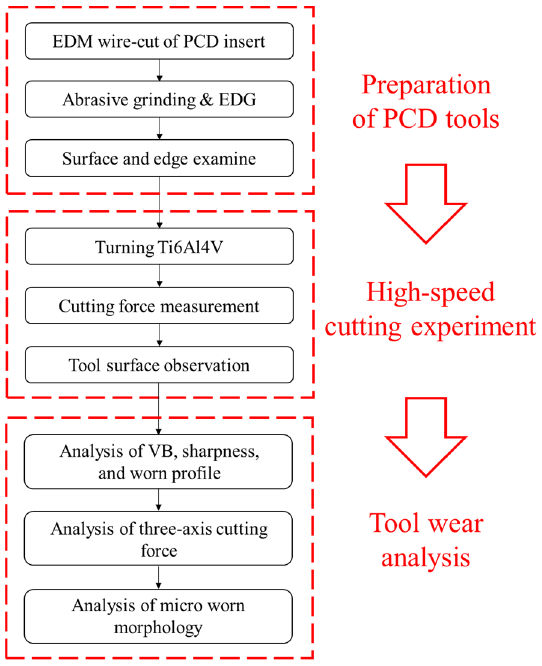
Figure 1. The flow chart of research methodology